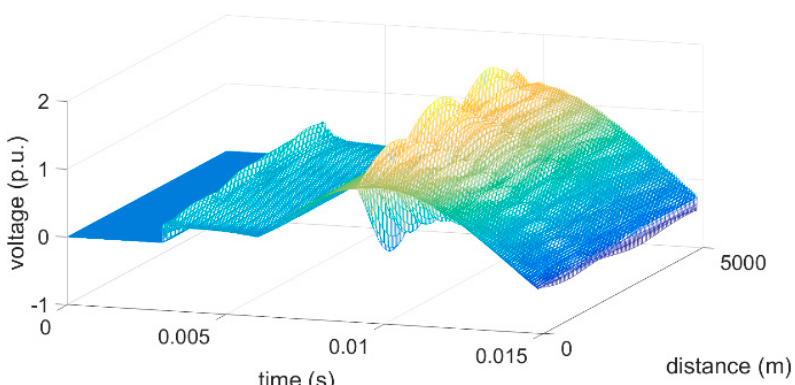
Figure 11. Transient voltage profile along phase B in example 3.2. The complete voltage profile induced in phase B due to the energization of phase A can be observed. This type of detailed information cannot be easily achieved using ATP-like simulation software.